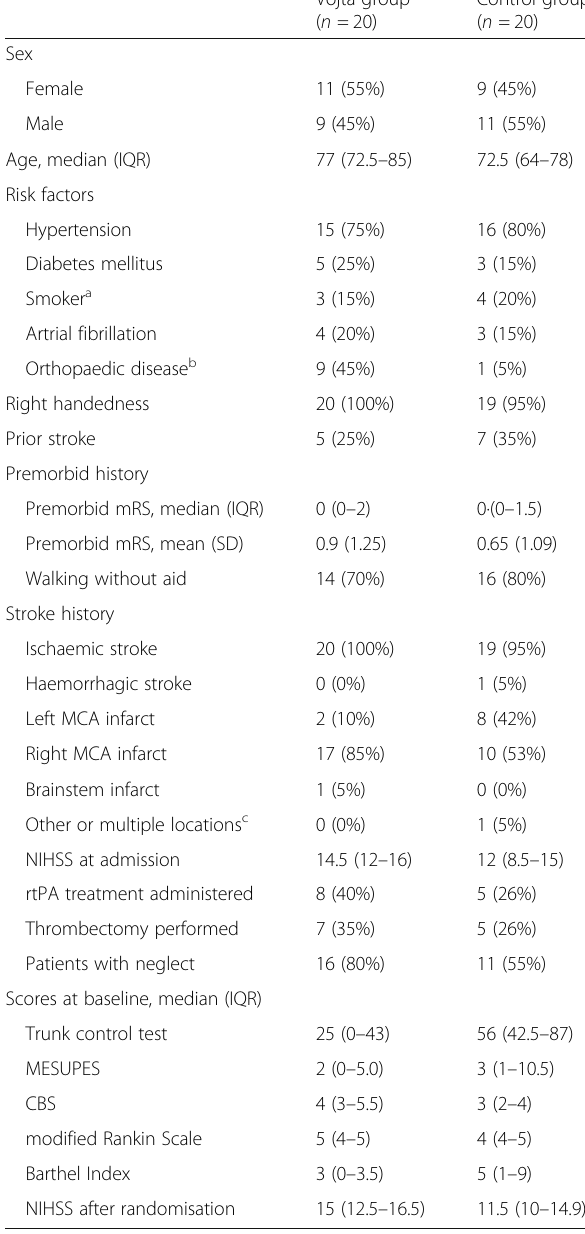
Table 2 Demographics and baseline clinical